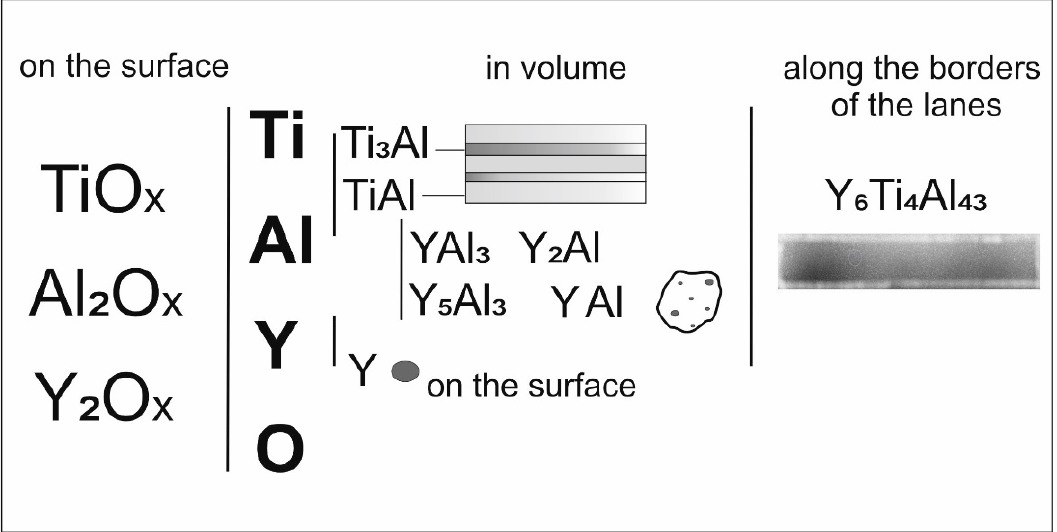
Figure 8. The localization scheme of the TAY alloy phases formed by the TAY hydride technology.